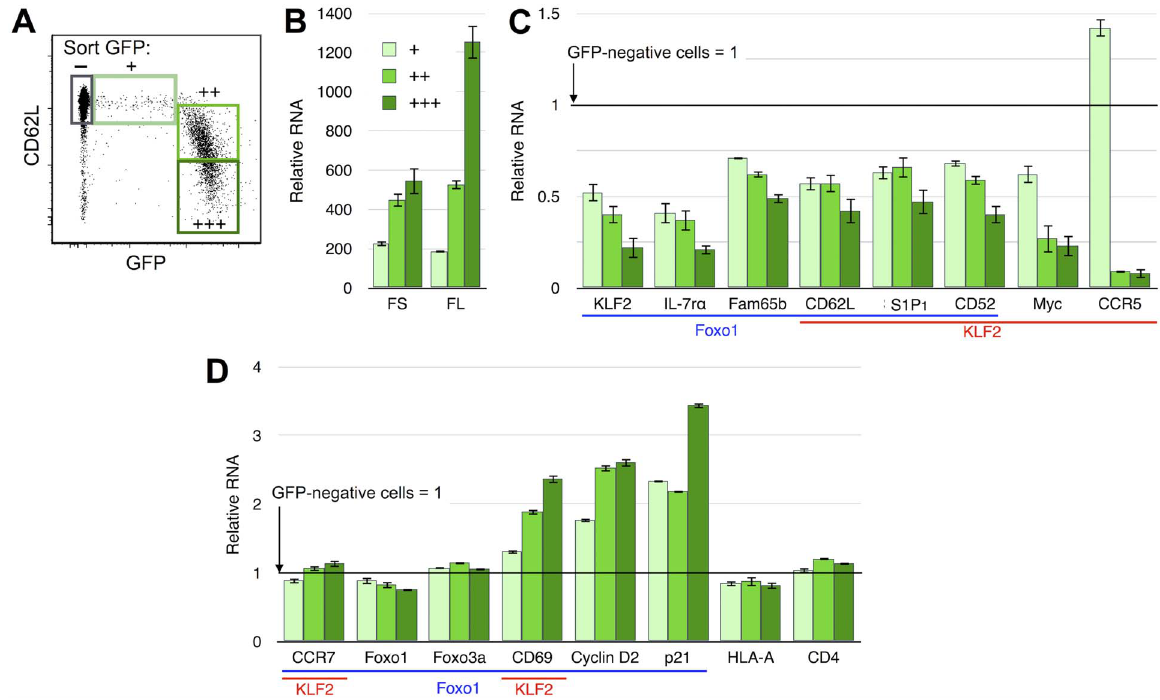
Figure 3. mRNA levels of several known Foxo1- and KLF2-regulated genes in HIV-1 infected naı¨ve CD4 + T cells. Data are representative of 3 independent experiments. Error bars represent SD of triplicate PCR reactions. A. CD45RO-CD4 + T cells were infected with sing- round GFP reporter virus for 7 days then sorted by FACS into 4 populations of GFP- and GFP + cells according to GFP and CD62L expression. B. HIV-1 early fully spliced RNA (FS) and late full length RNA (FL) in each group of sorted cells. Data are normalized to a value of 1 for the FS RNA in GFP- cells. GFP- FL RNA was 1.5. A synthetic RNA standard containing both the FS and FL targets was used in order to allow the FS and FL values to be directly compared. Values are presented in Table S2 in File S1. C. mRNA of genes that were suppressed in GFP + cells. Values are normalized to the GFP- cells set to a value of 1 for each gene. Genes regulated by Foxo1 or KLF2 are indicated by color-matched under lines. All p , 0.01 (paired T-test). D. mRNA of genes that were changed , 2 fold or were increased in GFP + cells. mRNA in GFP-negative cells is set to a relative value of 1 for each gene as in